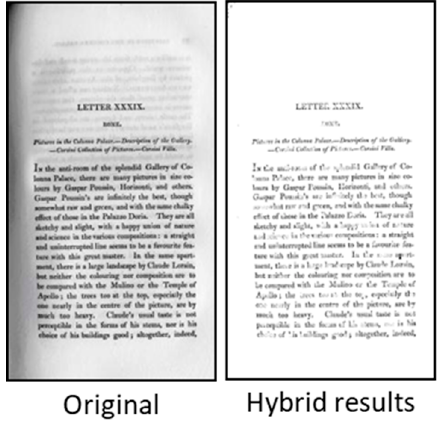
Figure 15. Example showing the results obtained using hybrid binarization method proposed by Sokratis et al [64].